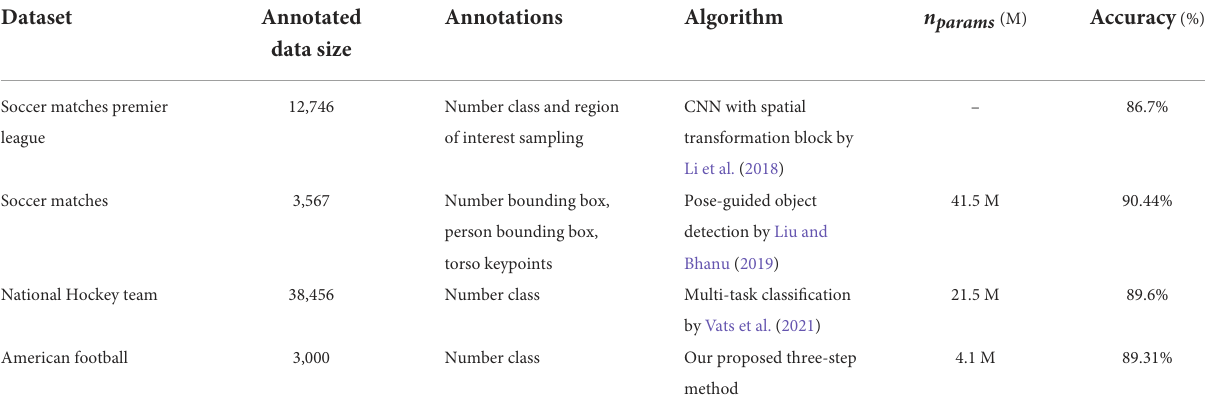
TABLE 3 Summary of published methods in comparison to the proposed